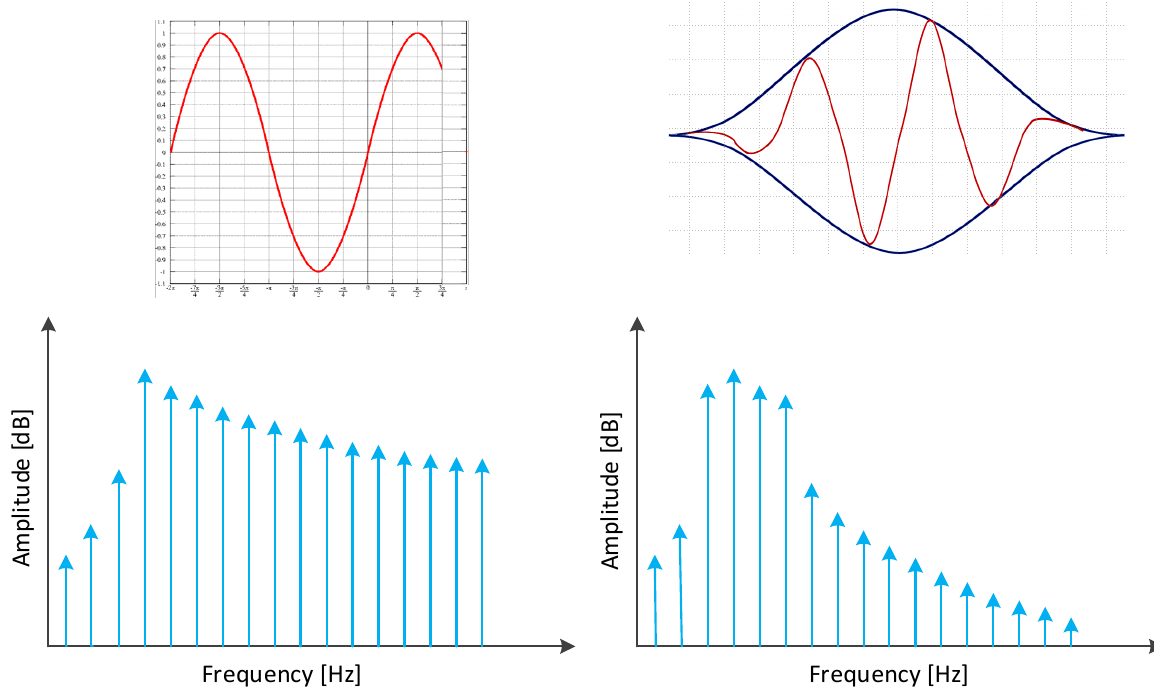
Figure 6. Representation of the Hanning window effect.